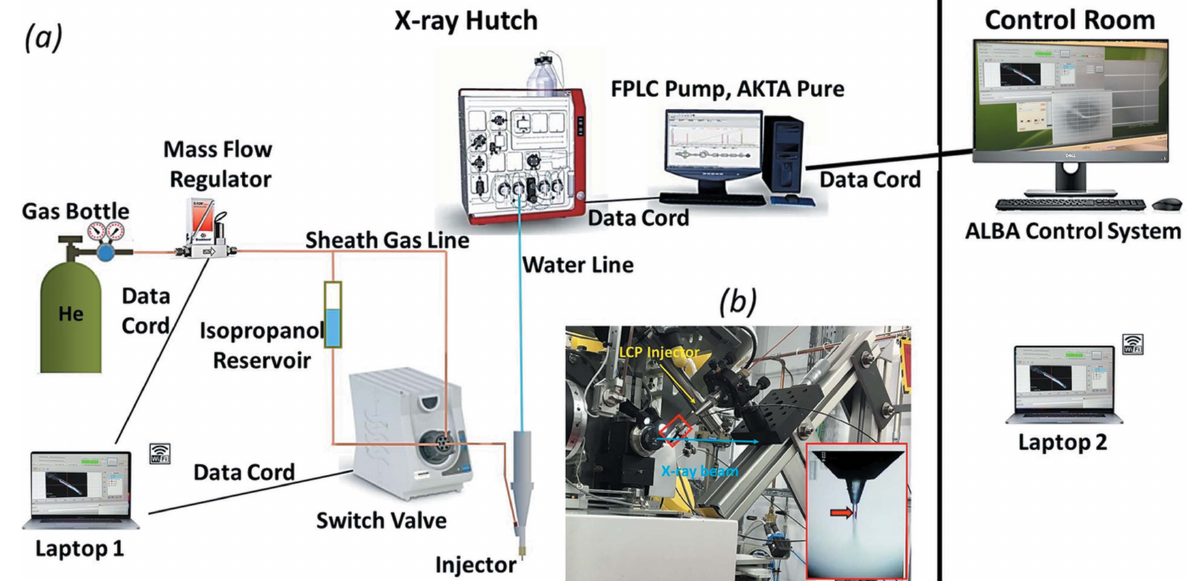
Figure 2 Experimental 45 (cid:4) set-up at BL13-XALOC. ( a ) Schematic diagram of the high-viscosity injector operation system showing all equipment and parts used for the set-up. A conventional FPLC pump was used. Helium was used as sheath gas in all our experiments. ( b ) High-viscosity injector (Weierstall et al. , 2014) mounted on translation stages. The inset panel shows a closer view of the LCP stream extruding from a 50 m m glass capillary nozzle. The red arrow indicates the position of the X-ray